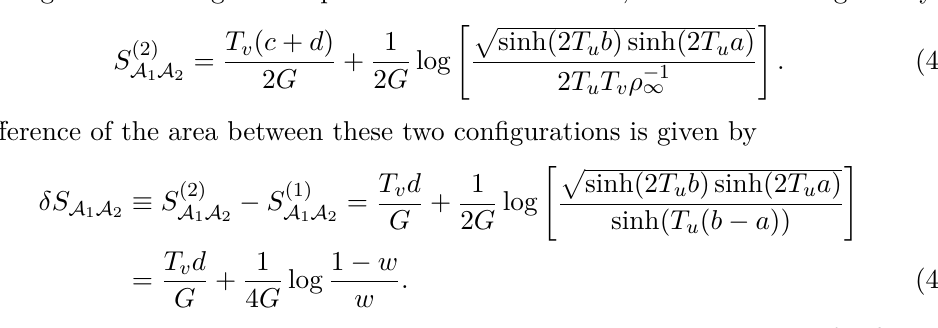
[ A ] contains the pre- C